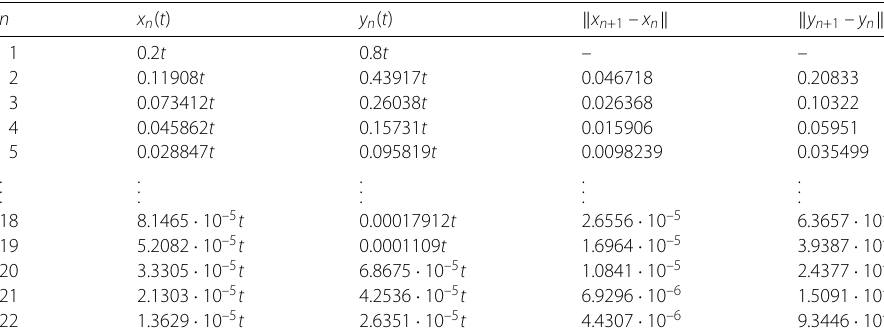
Table 2 Computational results of Case 1 for Example 5.2